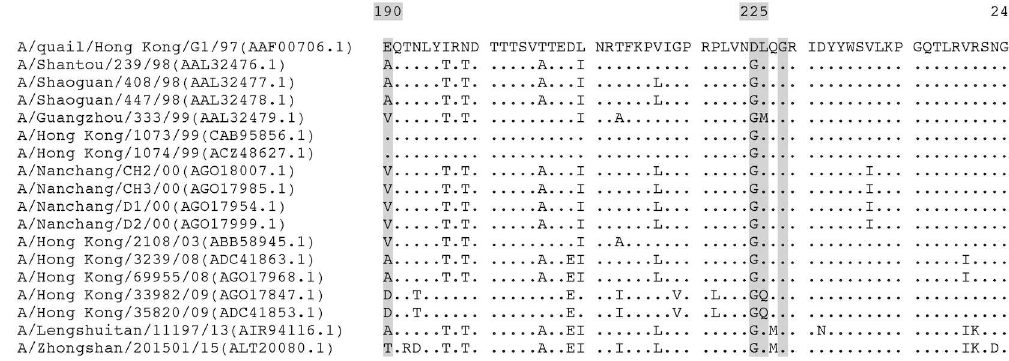
Fig 5. Alignment of deduced amino acid sequences in the HA of all human H9N2 isolates (n = 12) available in Genbank on 22 nd August 2016. Strain names are followedby accessionnumbers (betweenbrackets). Residuesat positions190, 225, 226 and 228 are highlighted in gray. Amino acids that are different from those in A/quail/Hong Kong/G1/1997 are shown, conservedresidues are shown as